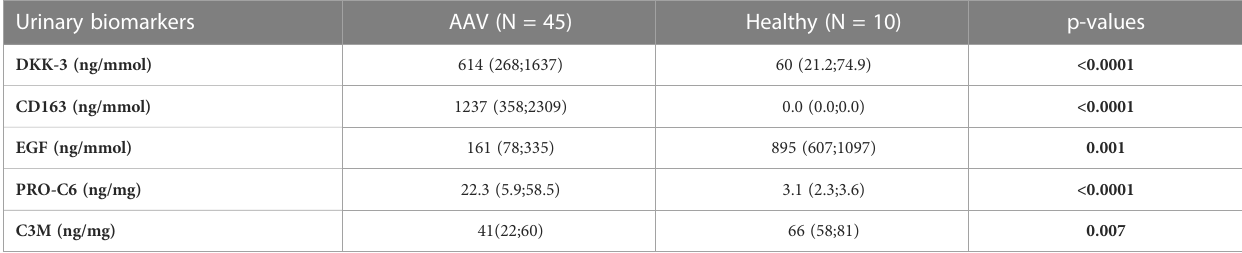
TABLE 2 Levels of urinary biomarkers in AAV patients and healthy controls.